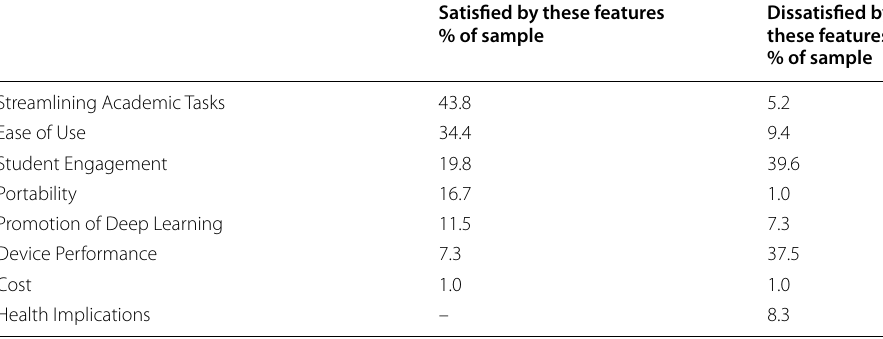
Responses often contatined multiple reasons, and were thus categorized in multiple categories